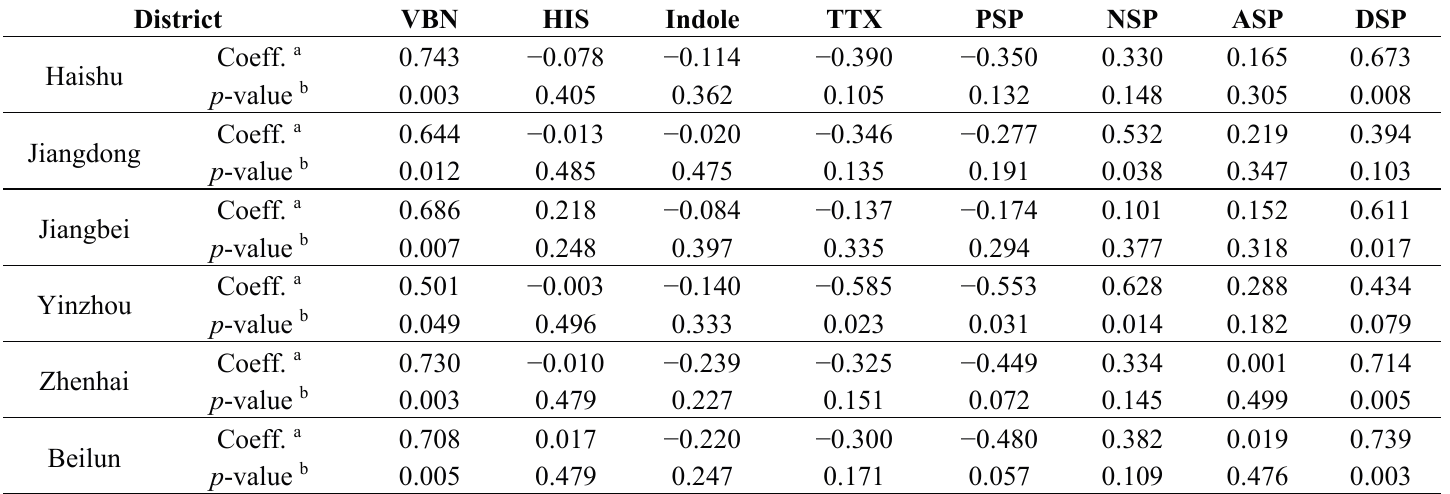
Table 6. The correlation of food-borne diarrhea and the monitoring index of live fresh aquatic products in different